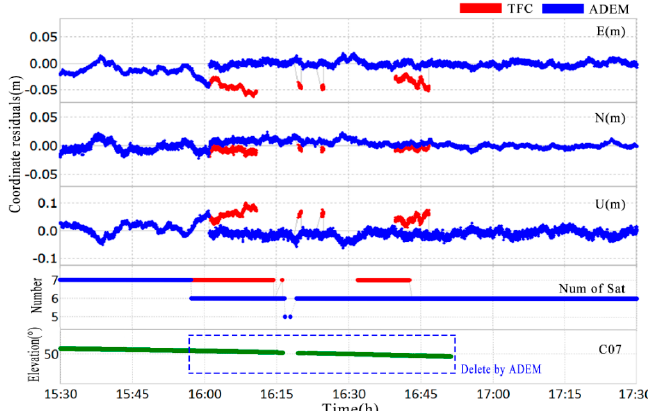
Figure 10. Deviation of the fixed coordinate time series using the TFC method (red) and the ADEM method (blue) from 15:30 to 17:30 for NQ02 ( top ); the number of satellites used for the estimation ( middle ); the session dealing with C07 for the ADEM method ( bottom ).